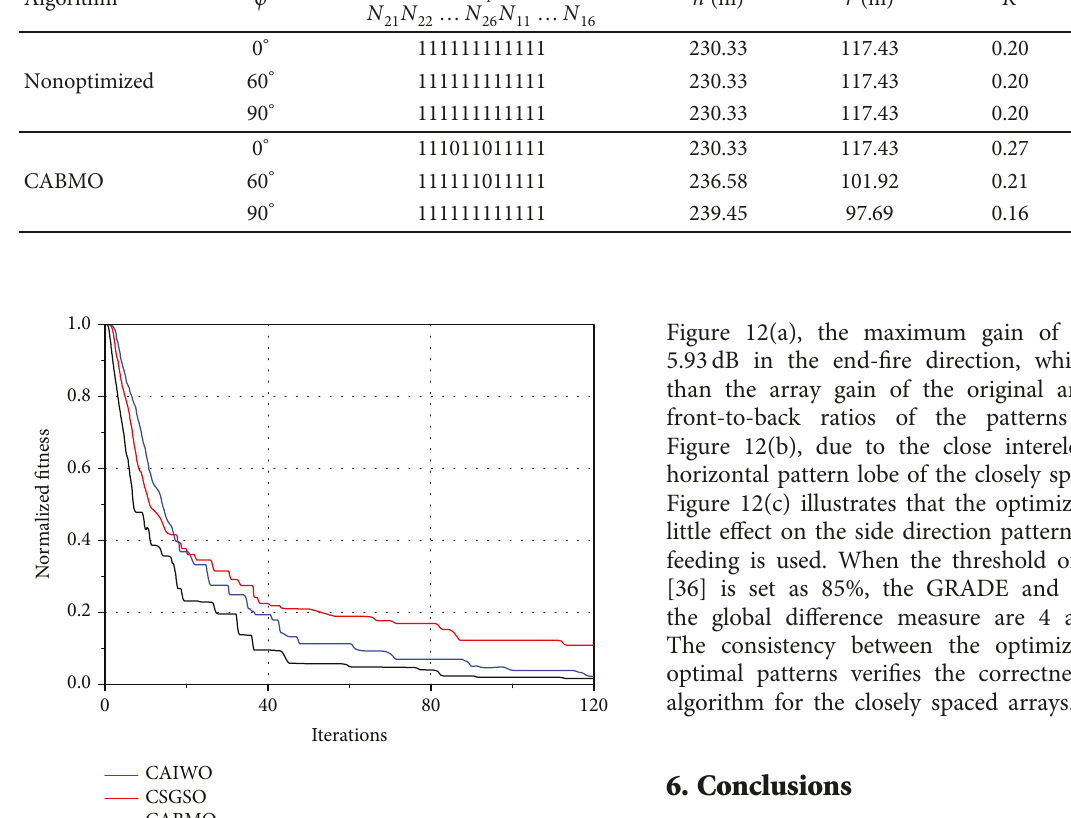
Table 9: The optimization variables obtained by the CABMO algorithm in 25kHz. Algorithm